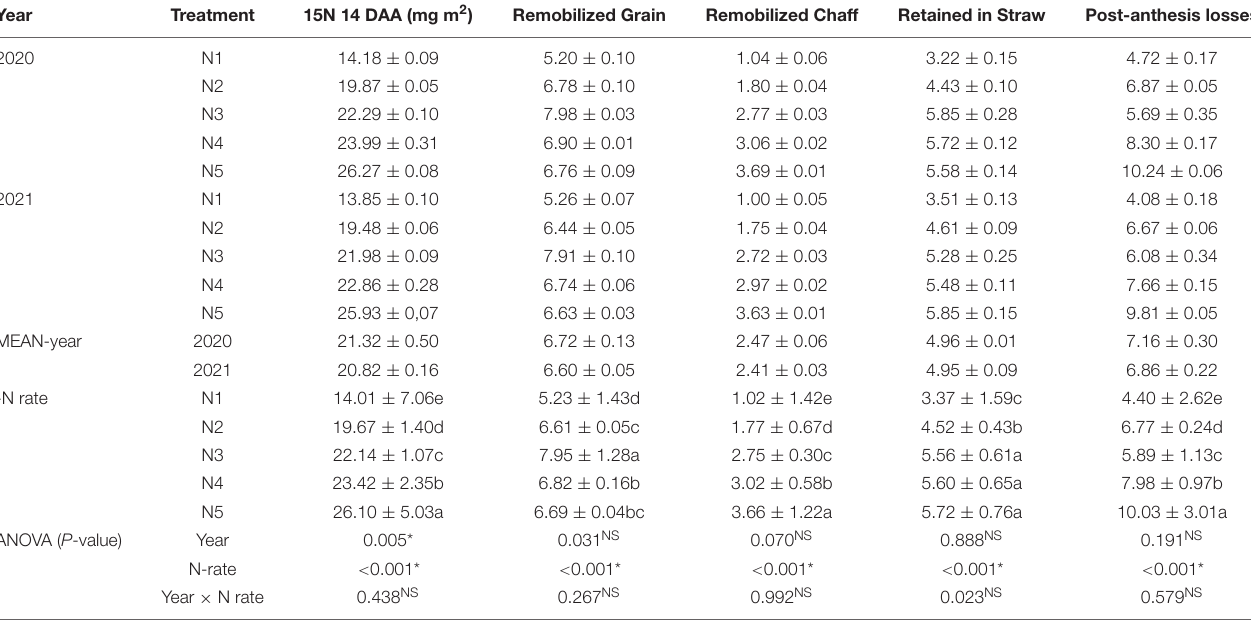
TABLE 5 | Post-anthesis effect of N fertilization on 15 N accumulated by the grain filling stage (14 DAA), losses and remobilization to the ears and grain between 14 DAA and maturity for spring wheat